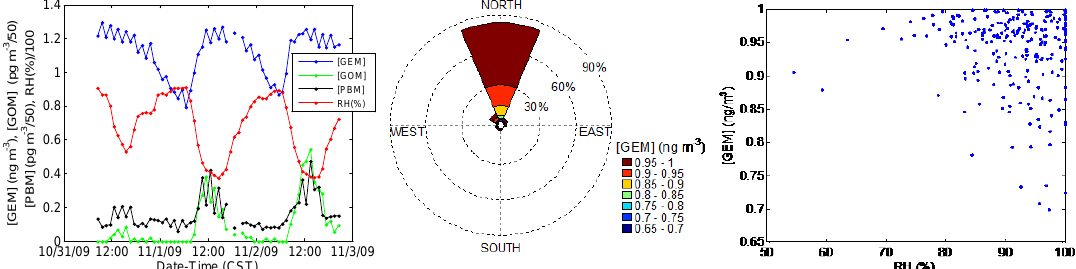
Figure 13. An example of GEM depletion events observed on 1–2 November 2009 ( left ), wind rose plot for GEM ( middle ) during GEM depletion events, and GEM versus RH ( right ) during GEM depletion events observed at the Grand bay site from 2007–2018. Data were filtered with [GEM] less than 1.0 ng m − 3 and were limited to the early morning hours only from 02:00–08:00 (CST) when the GEM depletion events occurred.